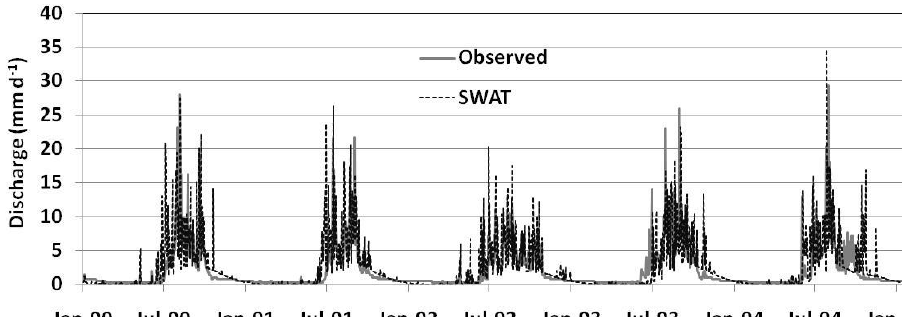
Fig. 6. Daily observed and predicted discharge from the Gumera subbasin.